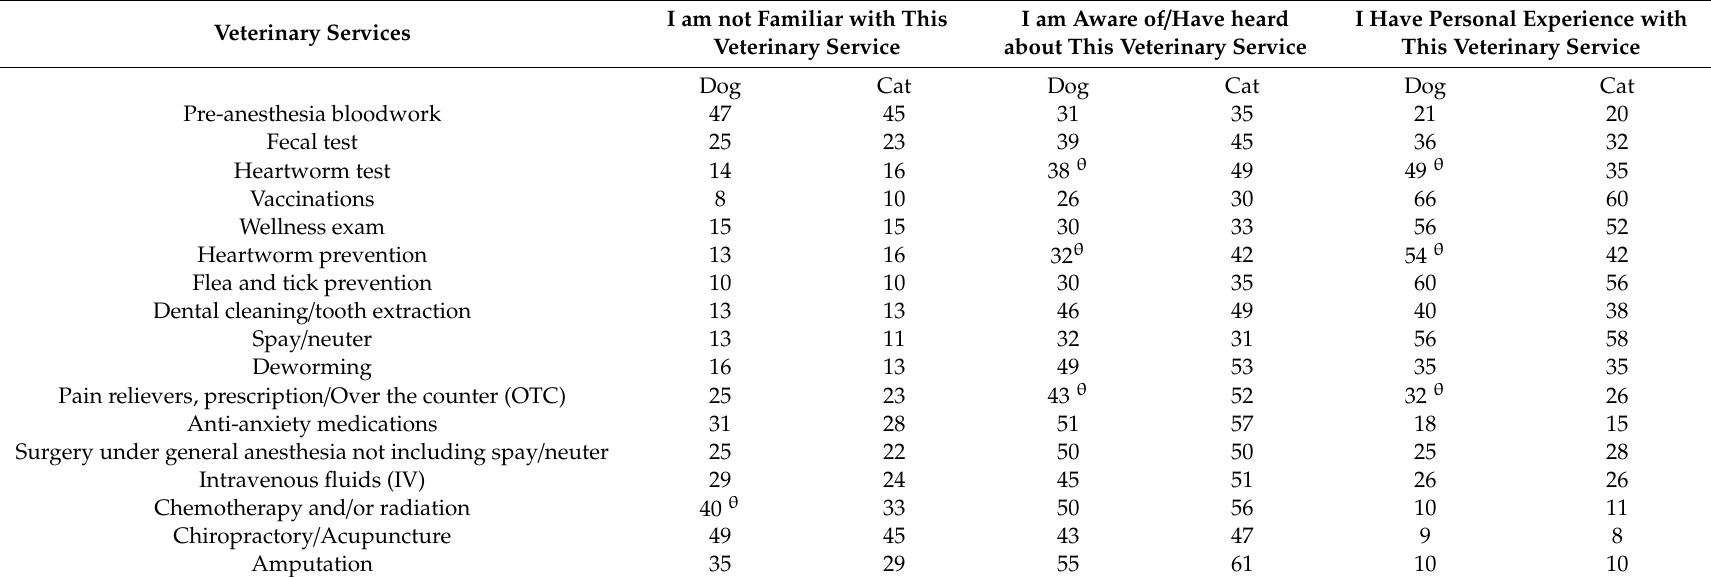
Table 7. Familiarity with veterinary procedures and statistical comparison between cat and dog owners, percentage of those who have or had a pet (dog n = 505, cat n =